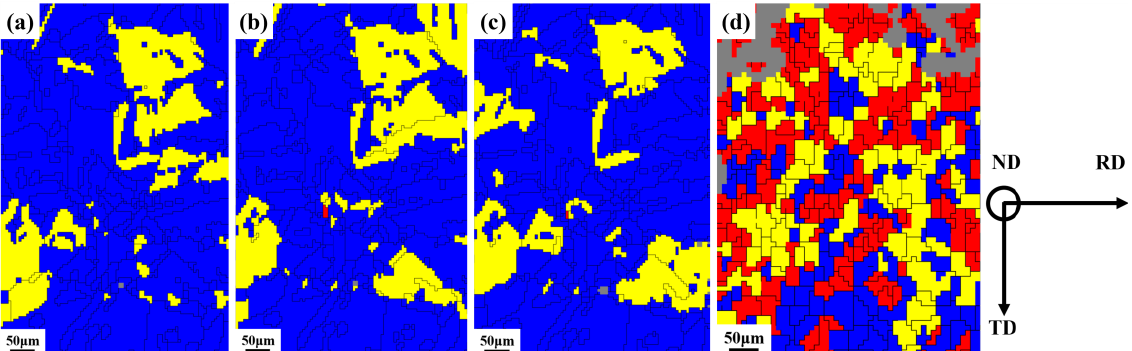
Figure 7. The evolution of geometrically necessary dislocation (GND) densities at different true strains.